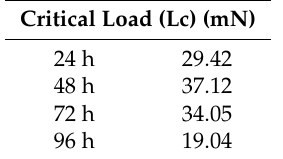
Figure 2. The critical load average values of the coatings held in SBF for ( a ) 24 h ( b ) 48 h ( c ) 72 h ( d ) 96 h critical load values held [12]. Table 7. The critical load average values of the HA coating depending on the holding time in SBF [12].